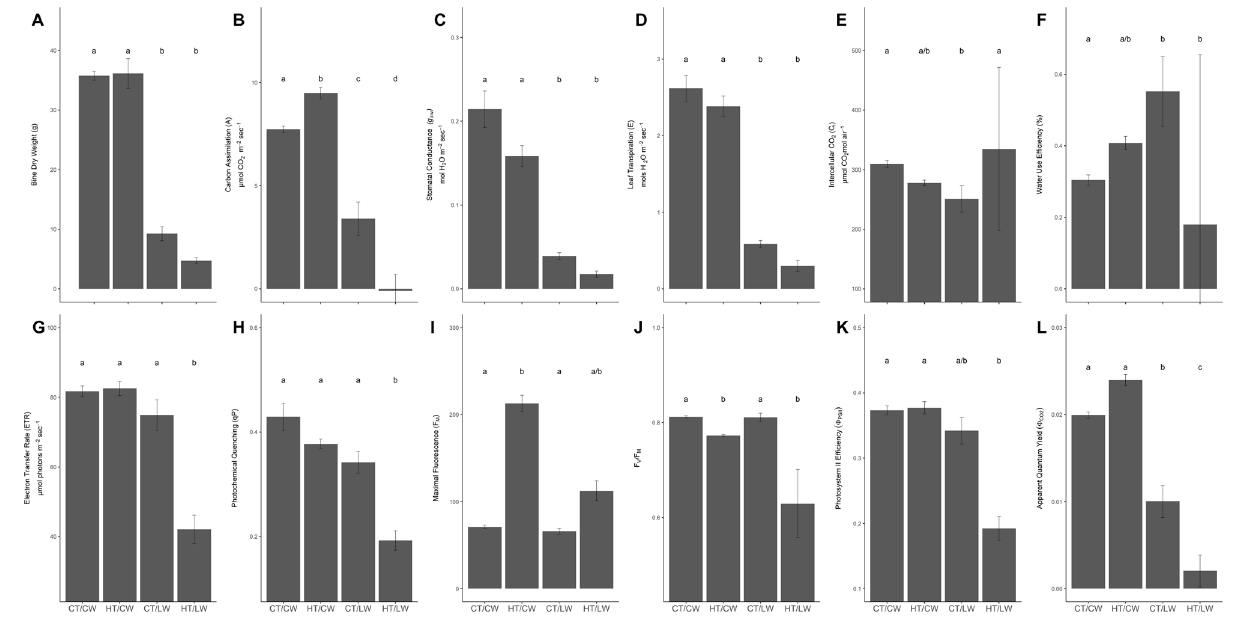
Figure 1. The average values of measured morphological and physiological traits taken prior to RNA-seq sampling. Letters above the bars represent statistical significance from ANOVA and Tukey HSD tests or Kruskal–Wallis and Dunn-tests. Error bars represent the standard error of the mean. ( A ) Bine dry weight (DW); ( B ) carbon assimilation ( A ); ( C ) stomatal conductance ( g sw ); ( D ) leaf transpiration ( E ); ( E ) Intercellular CO 2 (C i ); ( F ) water use efficiency (WUE); ( G ) electron transfer rate (ETR); ( H ) photochemical quenching (qP); ( I ) maximal fluorescence (F M ); ( J ) F V /F M ; ( K ) photosystem II efficiency ( ɸ PSII ); ( L ) apparent quantum yield ( ɸ CO2